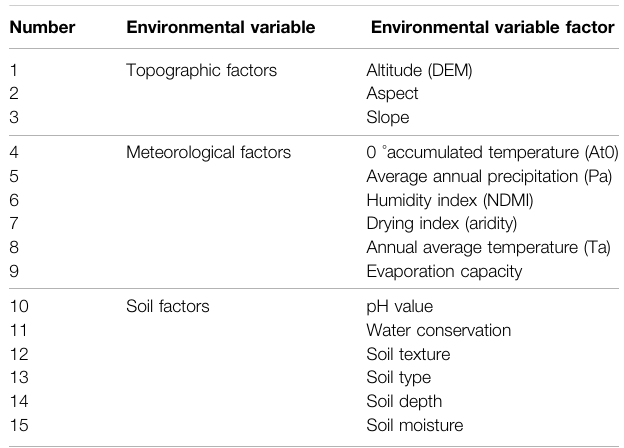
TABLE 1 | Environmental variable factors used in the